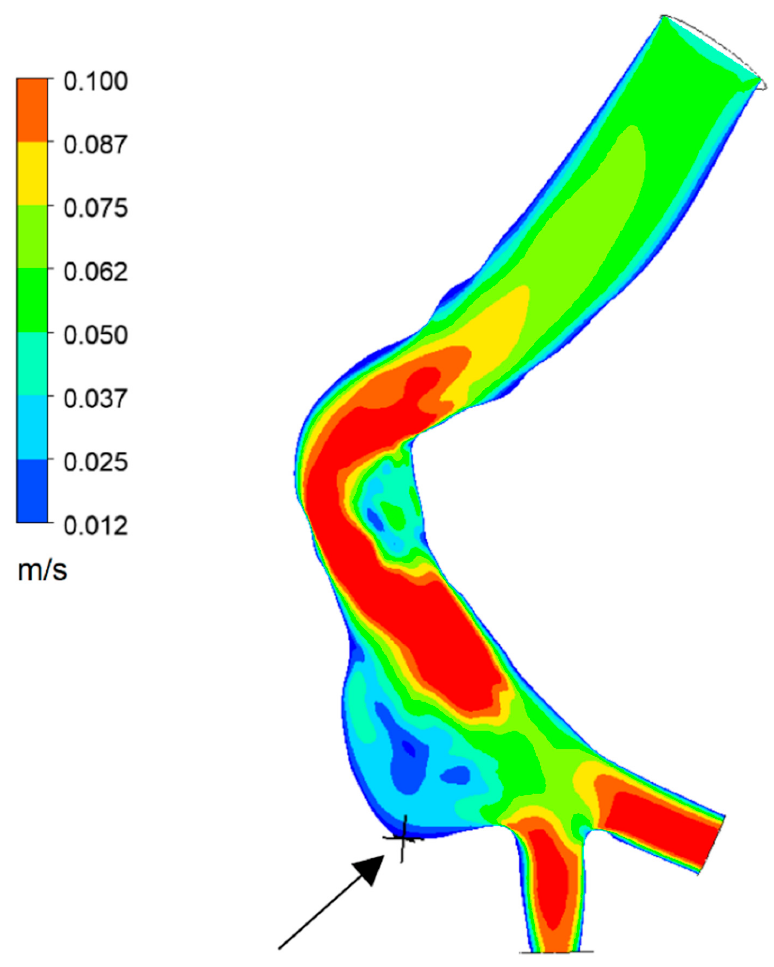
Figure 8. Time-averaged velocity contours on the longitudinal cross-section of the rupturing aneurysm. The arrow and the black cross indicate the region where rupture really occurred (future rupture region).